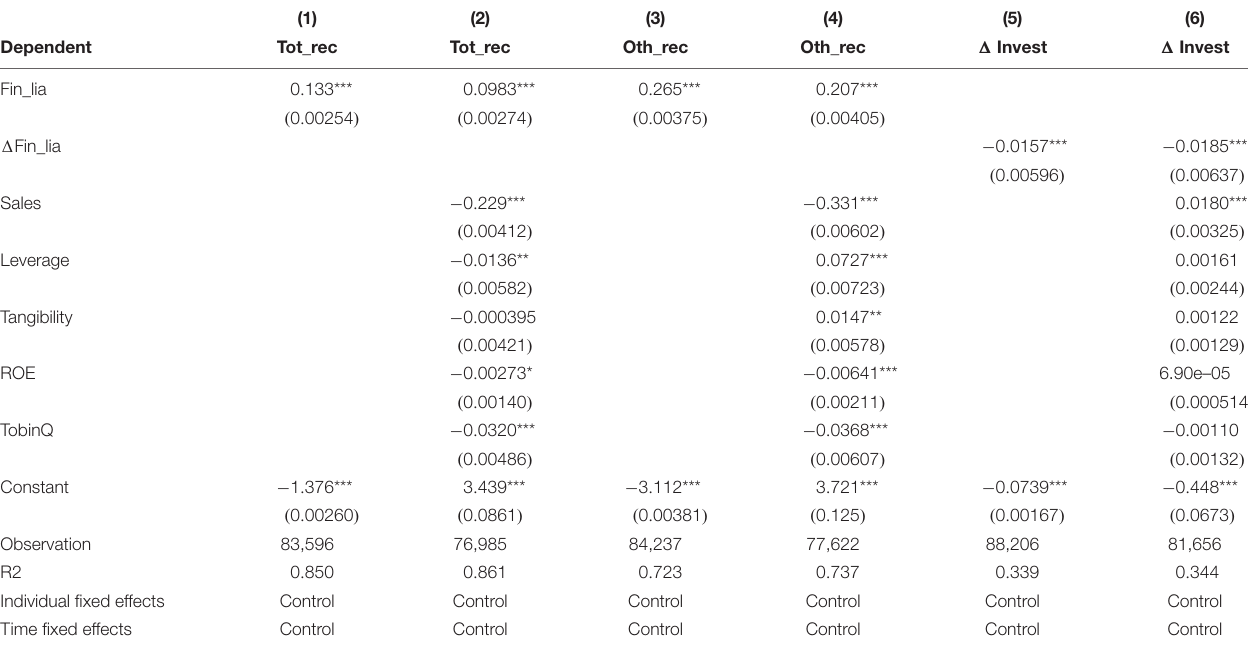
TABLE 4 | “Borrow to Lend” identification models 2 and